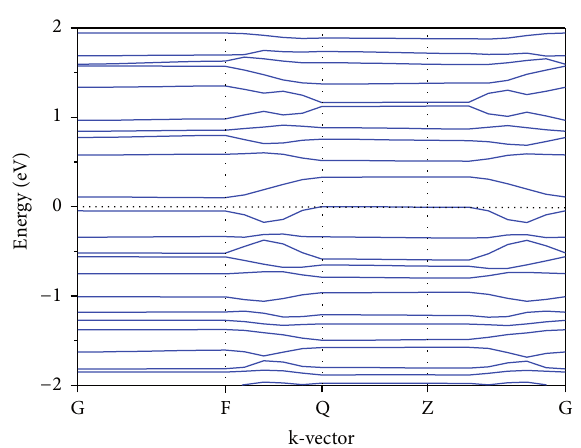
Figure 11: The electronic band structure of N1-doped single walled chiral (4,2) BNT. The Fermi level is set corresponding to zero energy and represented by dotted line.